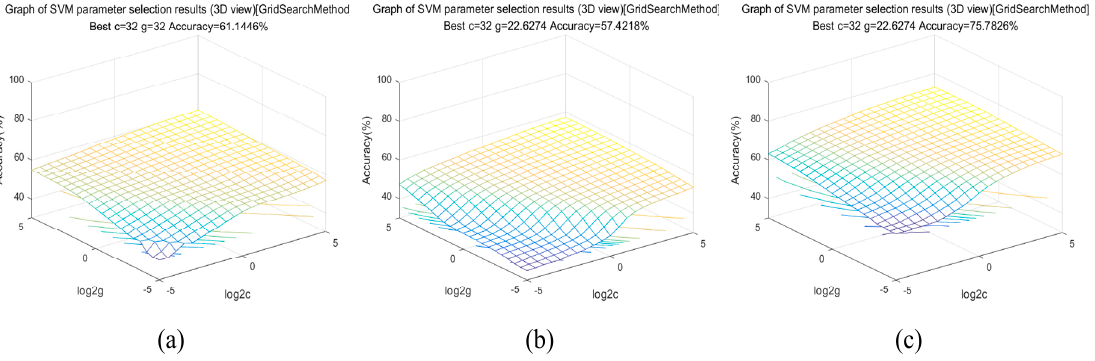
Figure 7. Grid search results for the support vector machine (SVM) model. ( a ) Optimal parameter search results for the PLS–SVM model; ( b ) optimal parameter search results for the SPA–SVM model; ( c ) optimal parameter search results for the Y–Net(band)–SVM model.